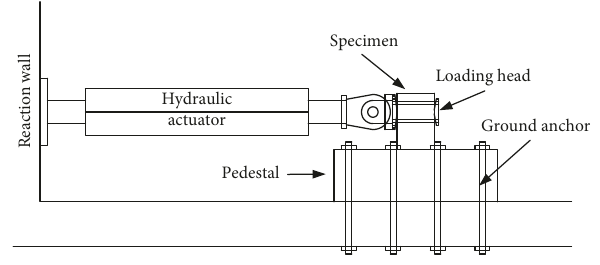
Figure 2: Schematic representation of test